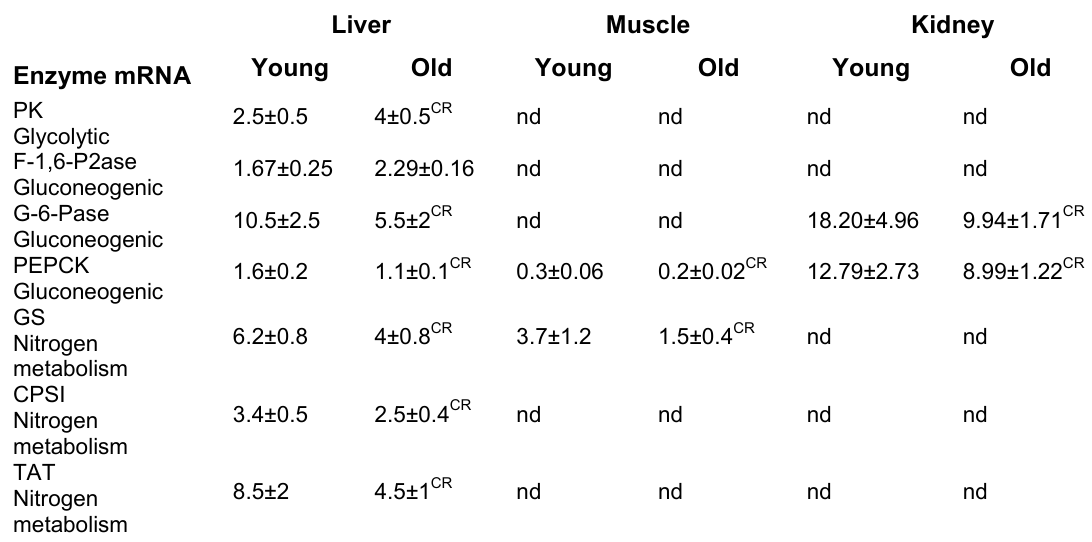
Differential Enzyme mRNA Levels Between Young (7 months old) and Old (28 months old) Mice Liver Muscle Kidney Young Old Young Old Young